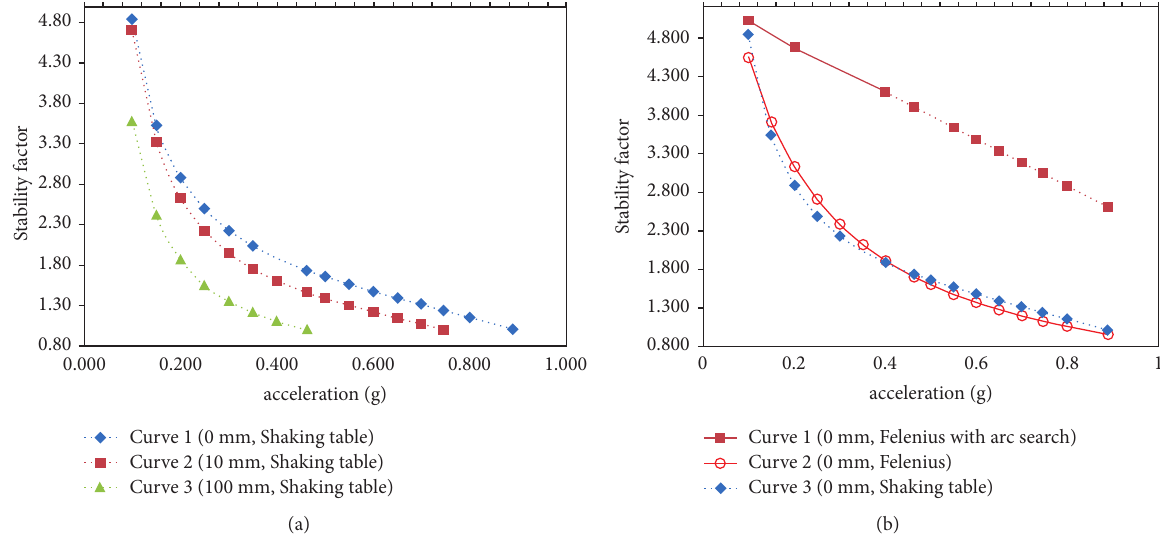
Figure 9: Slope stability factors calculated by different methods. (a) Stability factors with three rainfalls based on the shaking table test. (b) Stability factors calculated by different